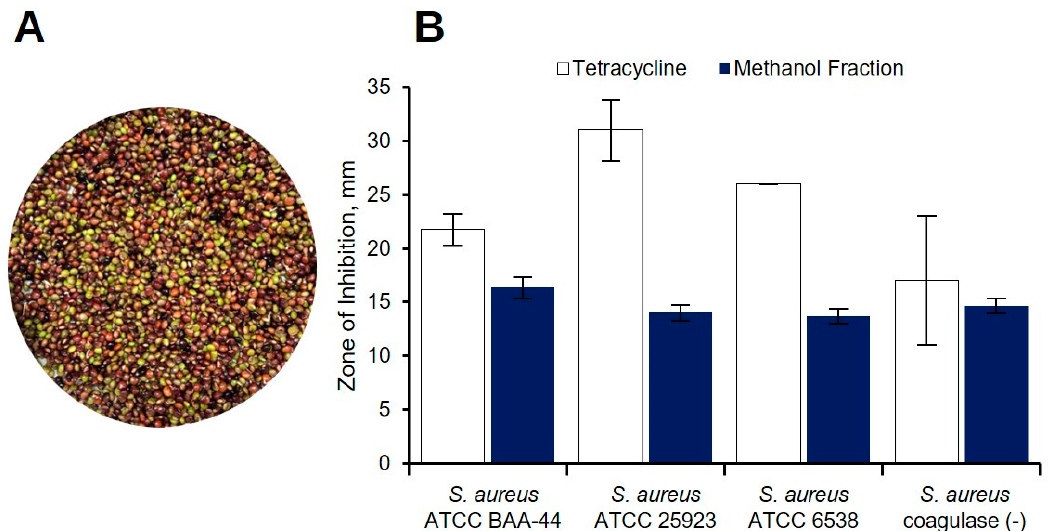
Figure 1. Antibacterial screening of C. cajan methanol fraction against four S. aureus strains. ( A ) Photo of C. cajan seeds. ( B ) Zone of inhibition ( ± SD) of KADAM fraction at 20 mg/well against the multidrug ‐ resistant S. aureus ATCC BAA ‐ 44, S. aureus ATCC 25923, S. aureus ATCC 6538, and S. aureus coagulase ( ‐ ), evaluated using agar well diffusion assay. Tetracycline was used as the positive control at a concentration of 0.25 mg/well against S. aureus ATCC BAA ‐ 44, S. aureus ATCC 25923, and S. aureus ATCC 6538 and 0.05 mg/well against S. aureus coagulase ( ‐ ) . DMSO was used as the negative control. Error bars represent the standard deviation. The assay was conducted in tripli ‐ cates.